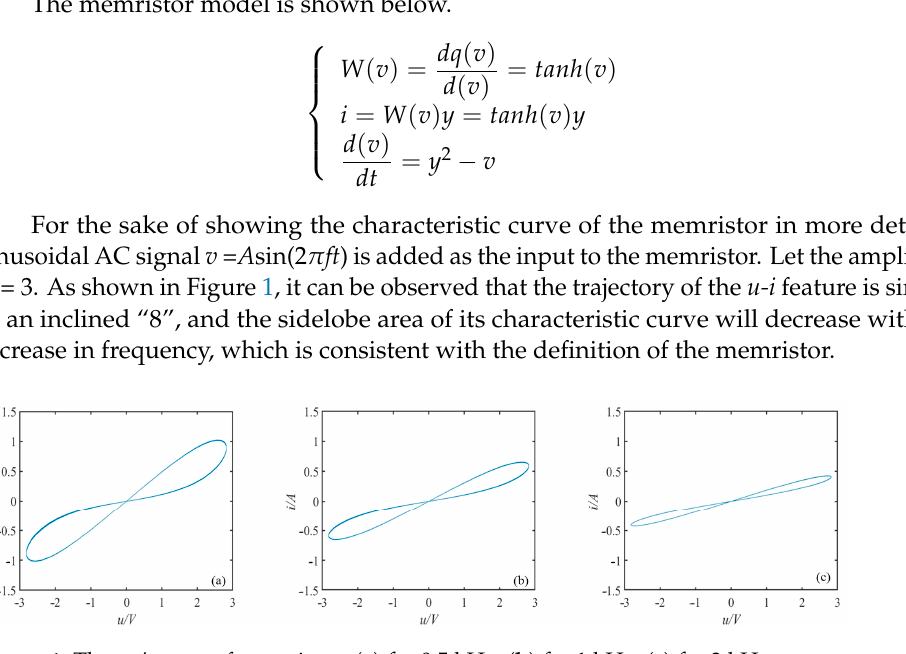
Figure 1. The u–i curve of memristor: ( a ) f = 0.5 kHz; ( b ) f = 1 kHz; ( c ) f = 2 kHz. Equilibrium Points Set and Stability